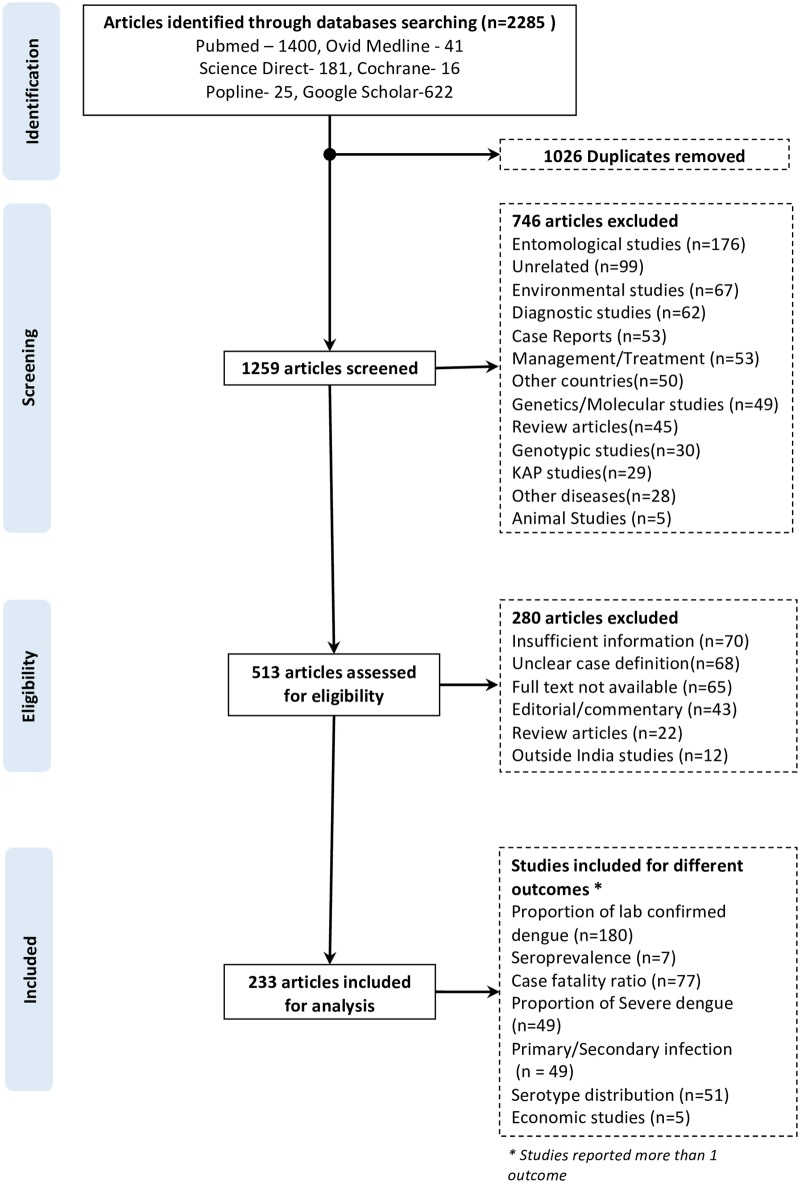
Flow diagram showing the article selection in the systematic review on dengue in India.